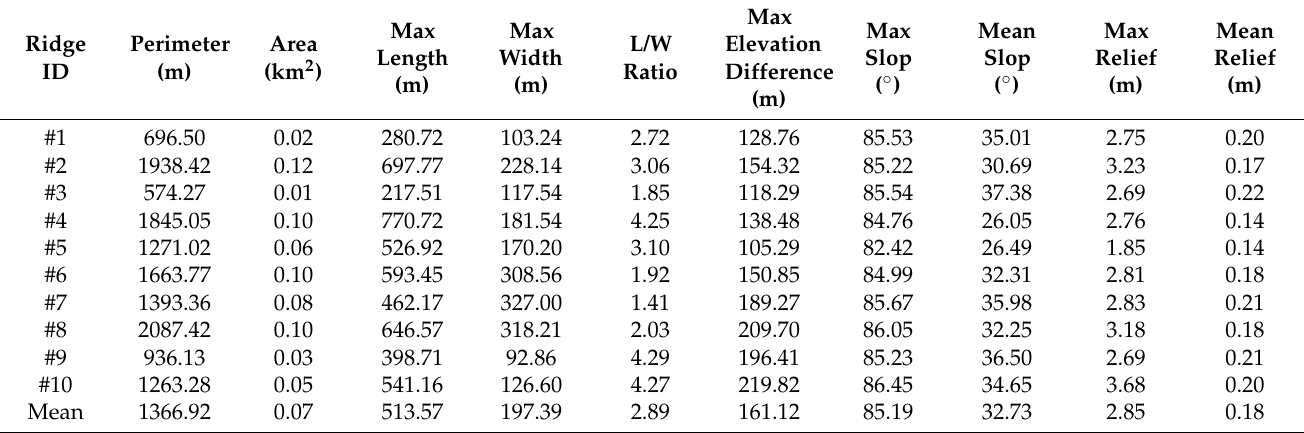
Table 3. Measurement results of morphological parameters of ridges.